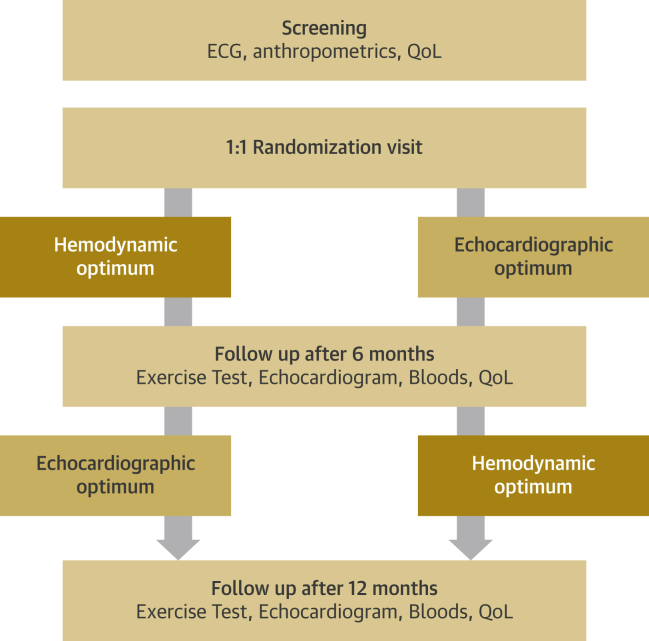
Flowchart of Study DesignPatients visited 4 times and underwent 2 atrioventricular and interventricular delay optimizations according to echocardiographic and hemodynamic protocols. ECG = electrocardiography; QoL = quality of life.